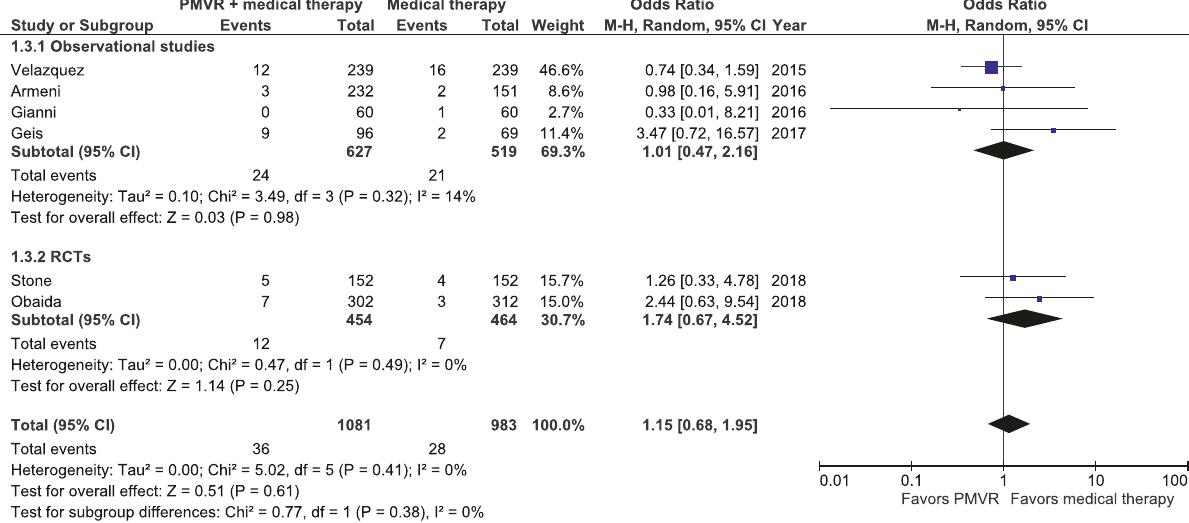
Figure 4: Meta-analysis displaying the risk of 30-day mortality in the PMVR group compared to the OMT group.